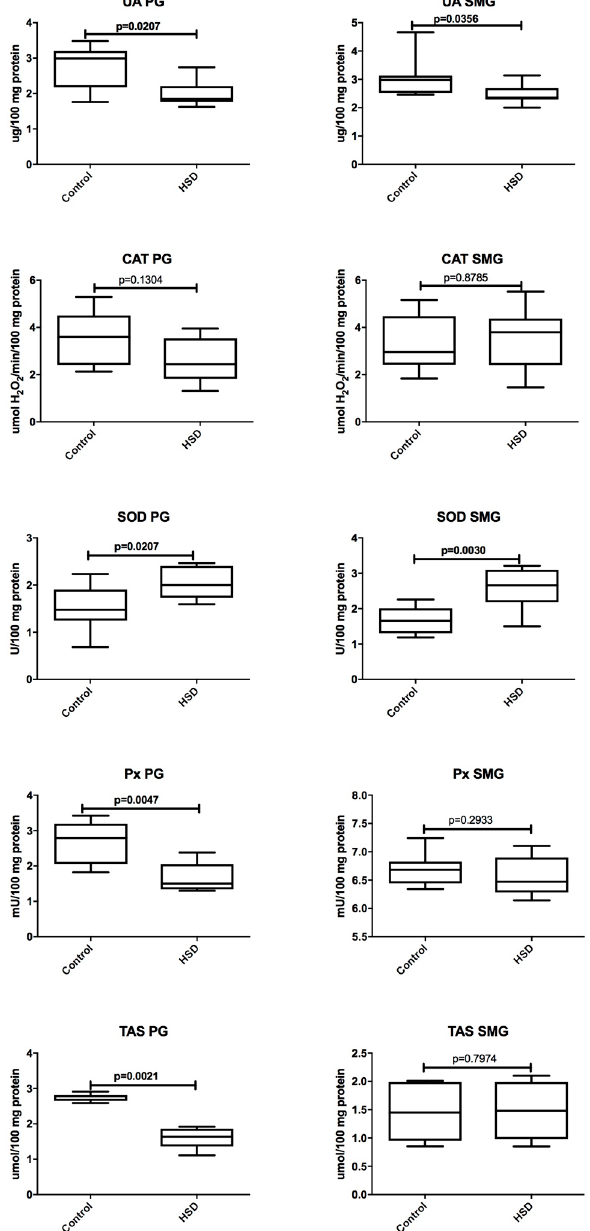
Figure 5. The effect of a high-sucrose diet (HSD) on the salivary glands’ antioxidant